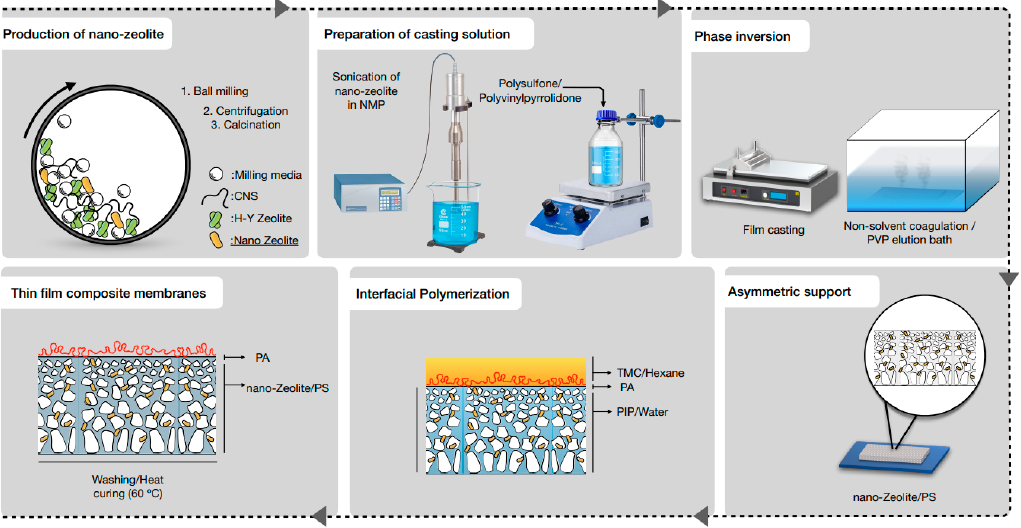
Figure 1. Membrane fabrication steps.